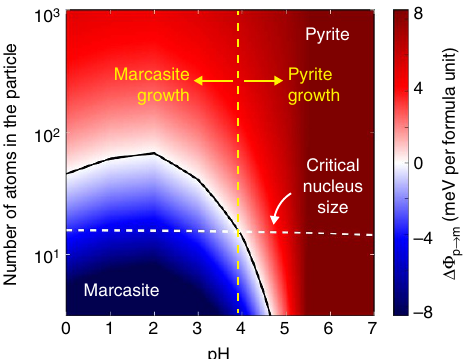
Figure 2 | Thermodynamics of nanoscale FeS 2 . The finite-size phase diagram of FeS 2 across a range of pH values, illustrating the low-particle- size, low-pH region of thermodynamic stability for marcasite. Note that we report a single critical nucleus size based on the experimentally reported supersaturation 15 for both pyrite and marcasite because the difference between the two is negligible.